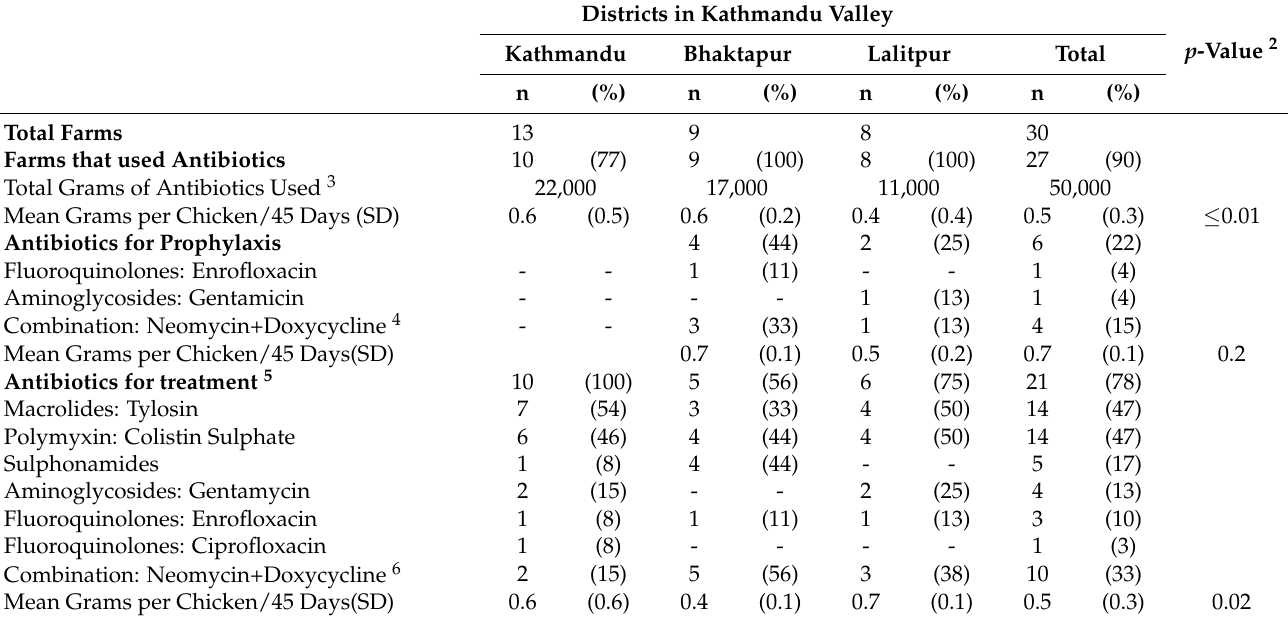
Table 1. Types of antibiotics used in large 1 broiler poultry farms in Kathmandu valley, Nepal (2019).